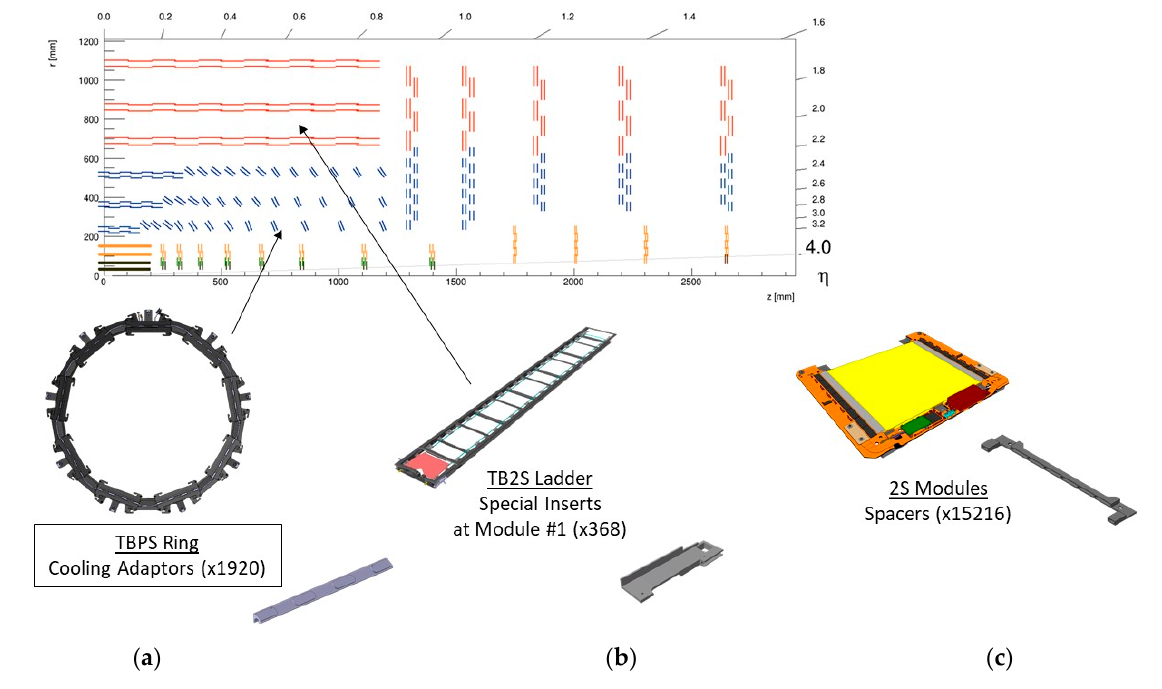
Figure 2. Al/C f components inside the CMS Outer Tracker. Al/C f is applied to produce parts for Rings ( a ), Ladders ( b ) and Modules ( c ). Parts made of Al/C f act as supports and thermal interfaces for the modules. The Al/C f parts needed for the Rings are triangular in shape; hence they have to be 3D machined. There are seven types, each with a specific angle.